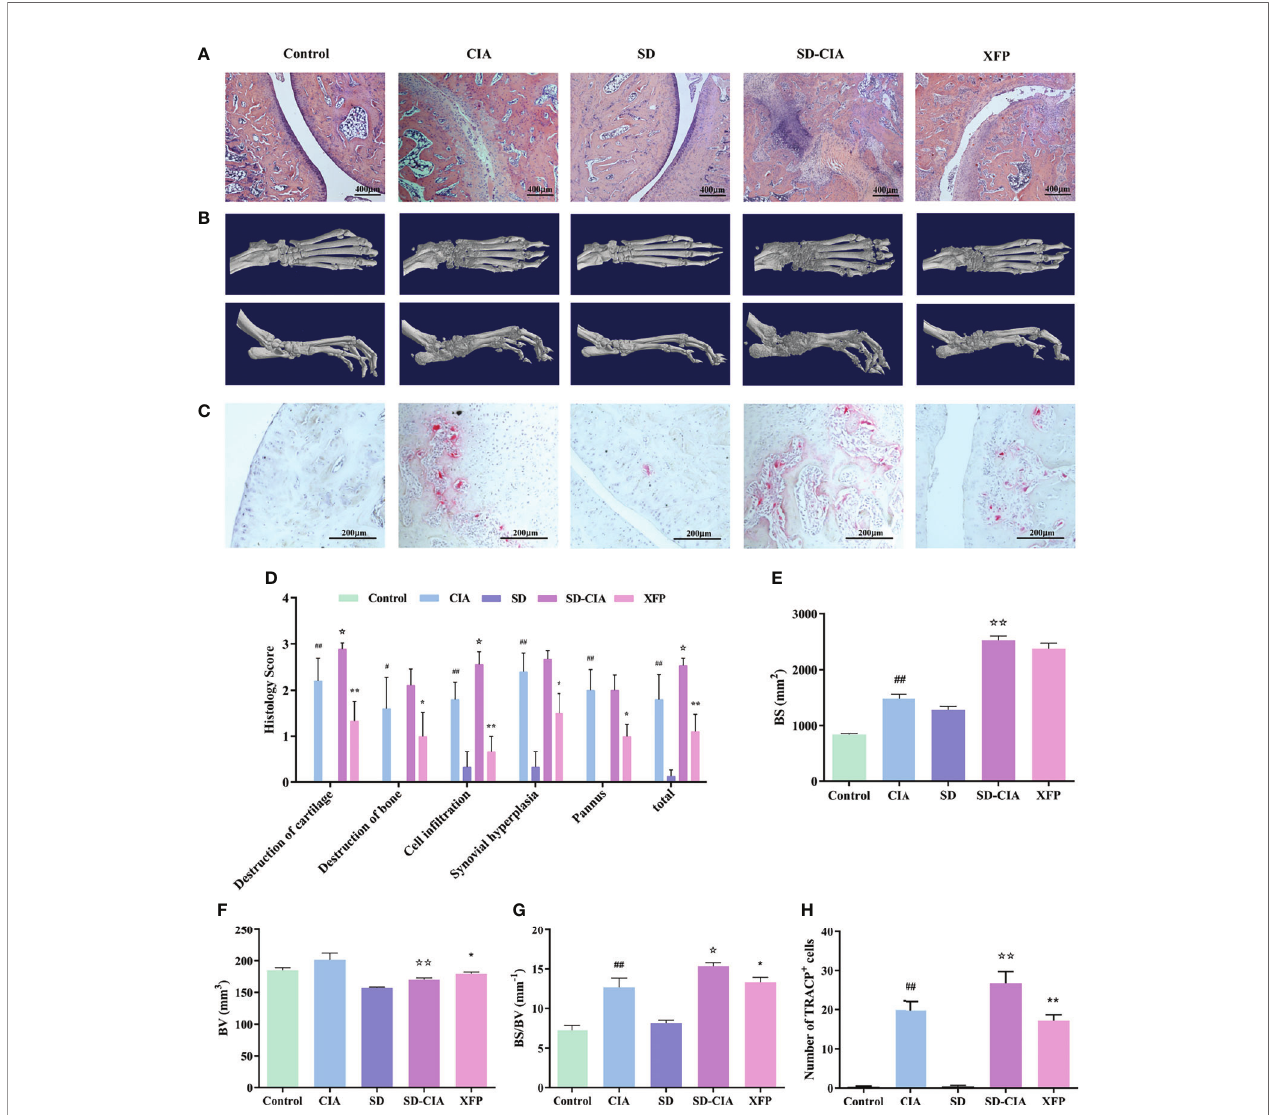
FIGURE 3 | Reduced bone destruction and joint damage effects of XFP in SD-CIA. (A) Representative images of ankle joint pathology shown through H&E staining. (B) Representative images of ankle joint micro-CT after treatment. (C) OCs in ankle was performed via TRACP staining. (D) Histological score of the ankle joints in each group shown by H&E staining. (E – G) Line plots showing the BS, BV, and BS/BV values of all groups. (H) OC counts after staining. The TRACP-positive multinucleated cells (>3 nuclei) were enumerated. n = 8. Data are presented as the mean ± SEM . # P < 0.05 and ## P < 0.01 compared to the control group; ☆ P < 0.05 and ☆☆ P < 0.01 compared to the CIA group; *P < 0.05 and **P < 0.01 compared to the SD-CIA group. XFP, Xiong Fu powder; CIA, collagen-induced arthritis; SD, spleen de fi ciency; SD-CIA, collagen-induced arthritis with spleen de fi ciency; micro-CT, microcomputed tomography; H&E, haematoxylin-eosin; OCs, osteoclasts; BS, bone surface; BV, bone